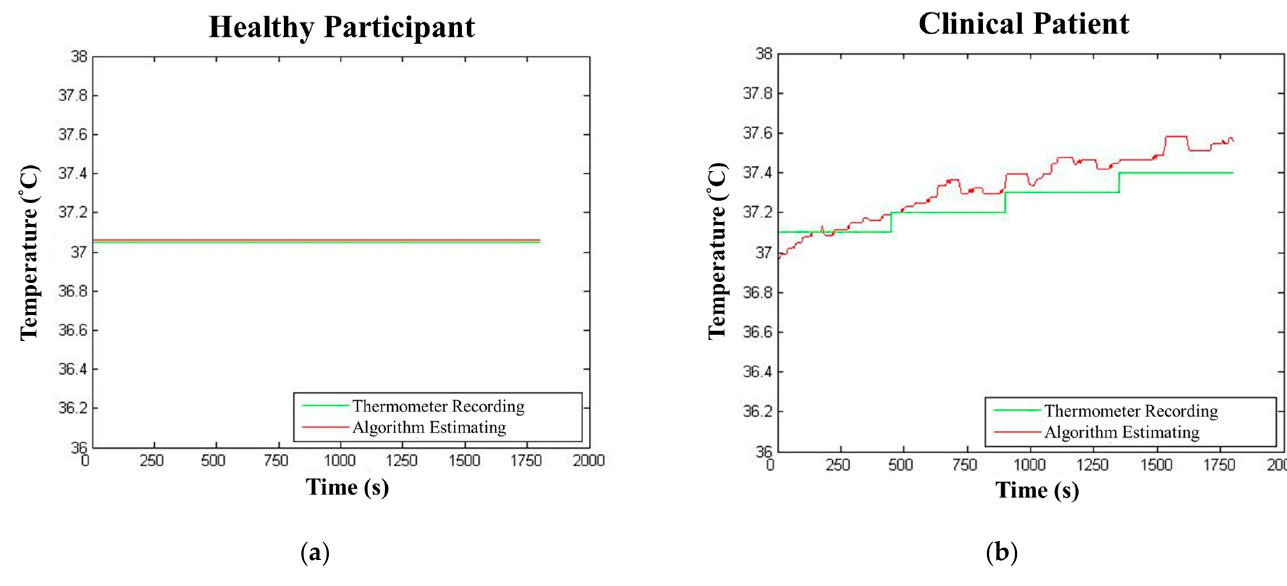
Figure 10. Continuous monitoring of measured and algorithm estimating values of ( a ) a healthy participant and ( b ) a clinical patient for the core body temperature algorithm. The measurement of core body temperature is represented in degrees Celsius (°C).